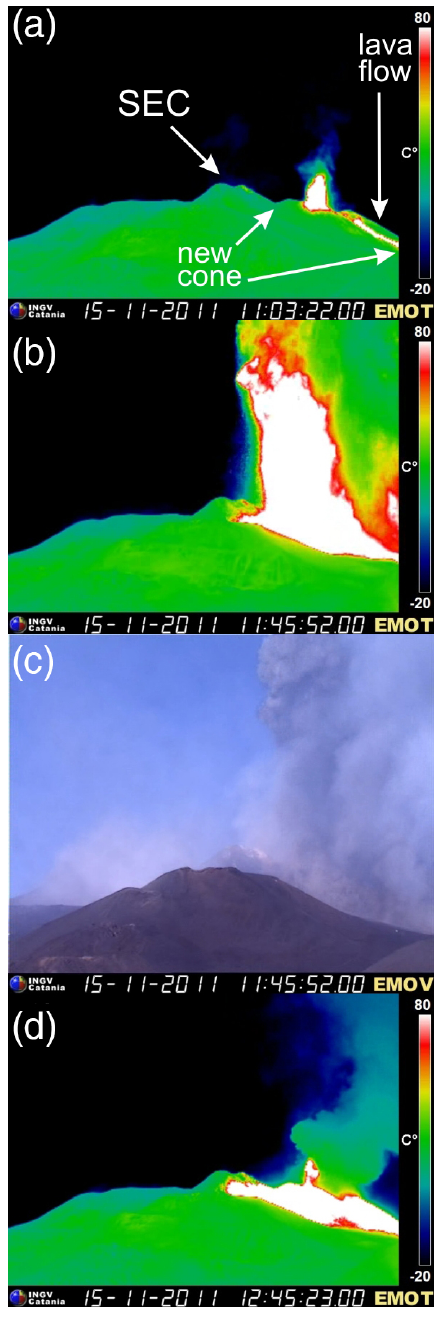
Figure 2. Images extracted from the INGV-OE video camera recordings of the La Montagnola site – (a, b, d) by the thermal camera; (c) by the true-colour camera, showing the main phases of the 15 November 2011 lava fountain at the new cone on the east flank of the SEC. Panel (a) shows the beginning of the explosive and effusive activity in the upper vent and eruptive fissure of the new cone, respectively; (b) lava fountains from the eruptive fissure; (c) the eruption column formed above; (d) the last explosions before the cessation of all eruptive phenomena.